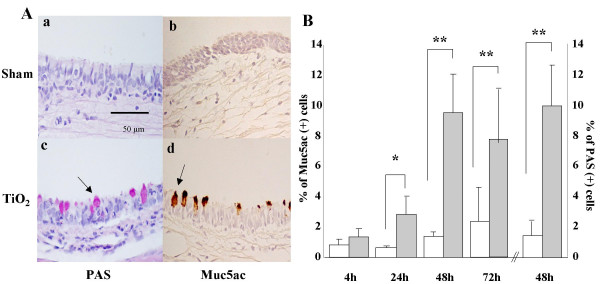
Light microscopic analysis of the trachea and the percentage of Muc5ac, PAS (+) epithelial cells. Rats were treated intratracheally with saline or TiO2, and the tracheas were prepared for morphometric analysis of PAS (+) and Muc5ac (+) cells as described in Methods. A. Histology of trachea 24 hr after saline or TiO2 treatment. PAS (+) cells were stained red whereas Muc5ac (+) cells dark brown. Note that the trachea obtained from the saline-treated group contained little or no PAS (+) (Aa) or Muc5ac (+) cells (Ab) while the trachea from TiO2-treated group contains significant number of PAS (+) (Ac) and Muc5ac (+) cells (Ad). B. Time (4, 24, 48,72 h) dependent change in the percentage of Muc5ac (+) cells following saline (open bar, n = 8) or TiO2 treatment (closed bar, n = 8). Note that the percentage of PAS (+) cells was similar to that of Muc5ac (+) cells at 48 hr after TiO2 instillation. * p < 0.05, ** p < 0.01 as compared with the saline treated group.